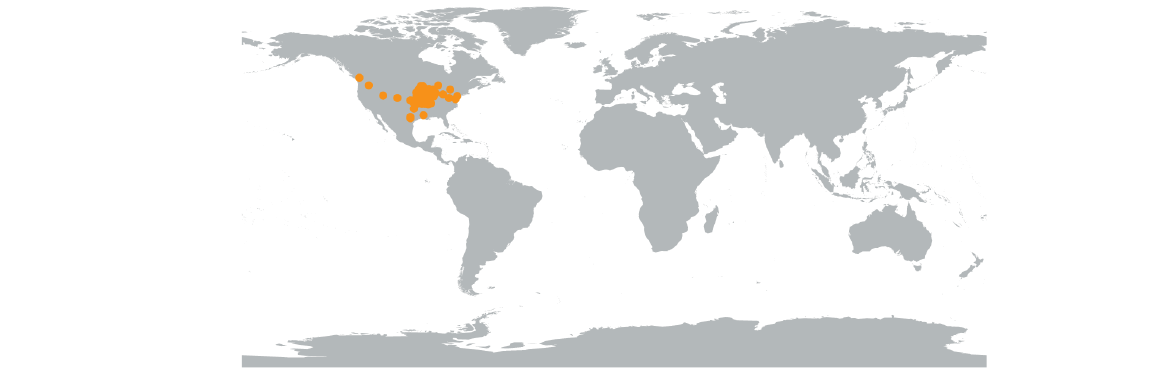
Fig. 49. Distribution of Malus ioensis (Alph.Wood)